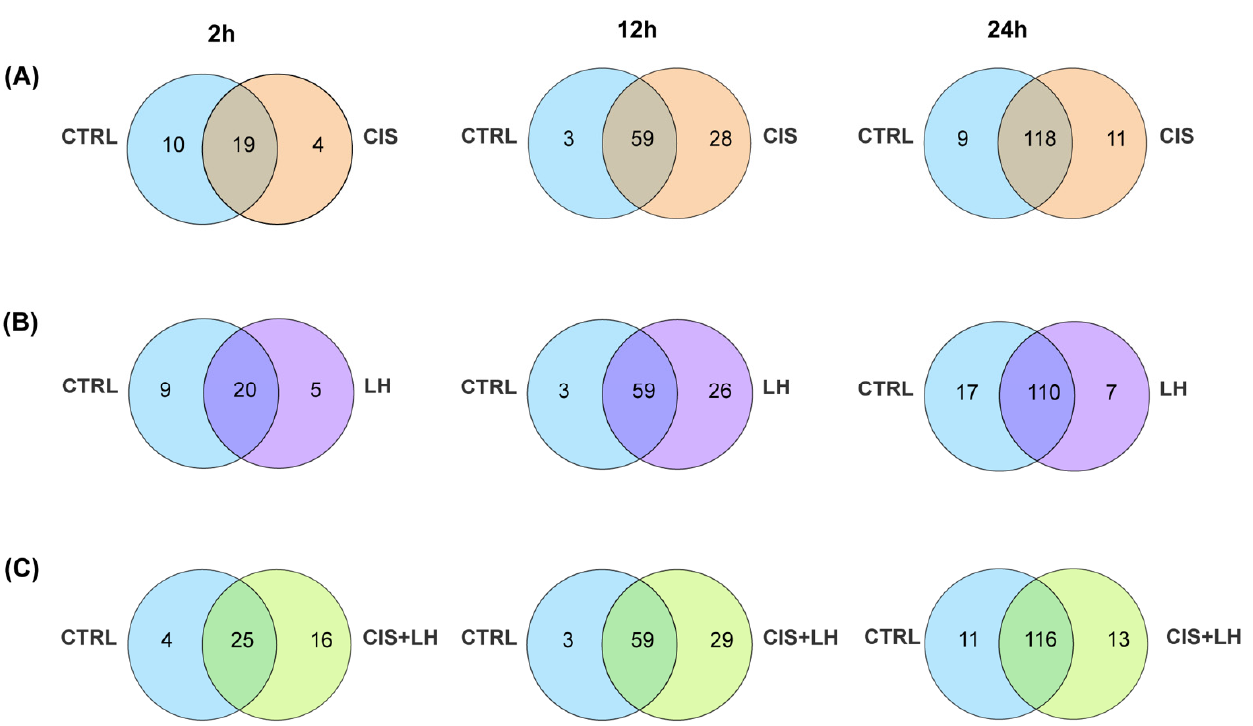
Figure 4. Venn diagrams showing unique and shared proteins between CTRL and the other experi- mental conditions. The numbers indicate the metabolites counts in the indicated area. ( A ) Overlaps between CTRL and CIS at 2, 12, and 24 h of treatment. ( B ) Overlaps between CTRL and LH at 2, 12, and 24 h of treatment. ( C ) Overlaps between CTRL and CIS + LH at 2, 12, and 24 h of treatment.